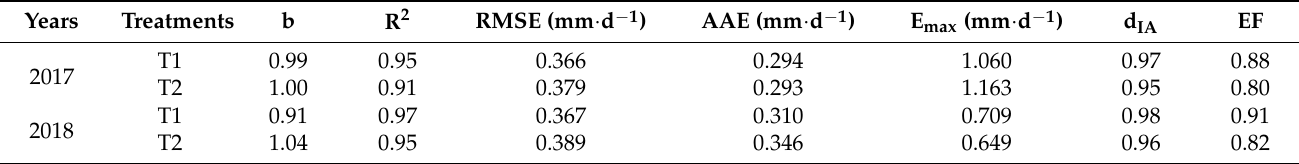
Figure 5. Seasonal variations of simulated evapotranspiration (ET c ), transpiration (T r ), and soil evaporation (E s ), and measured T r for two water treatments (T1 and T2) with days after planting (DAP) during the whole growth period of maize in ( a , b ) and 2018 ( c , d ). Table 5. Statistical indicators of goodness-of-fit between measured and simulated seasonal plant transpiration (T r ) for the two treatments (T1 and T2) in 2017 and